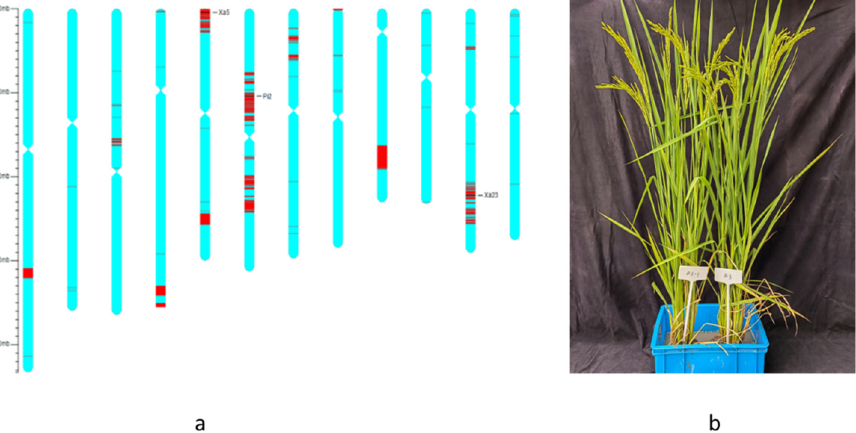
Figure 2. Genetic background assay and phenotype of the improved NIL. ( a ) The black lines indicate the positions of three target genes, xa5 on chromosome 5, Pi2 on chromosome 6, and Xa23 on chromosome 11. The red lines indicate the SNP loci with homozygous genotypes where genomic fragments of the donor parents were introgressed. The green lines indicate the SNP loci with the same genotypes as the recurrent parent Hanhui3. ( b ) The phenotype of the improved NIL and recurrent parent. Left is NIL. Right is recurrent parent Hanhui3.